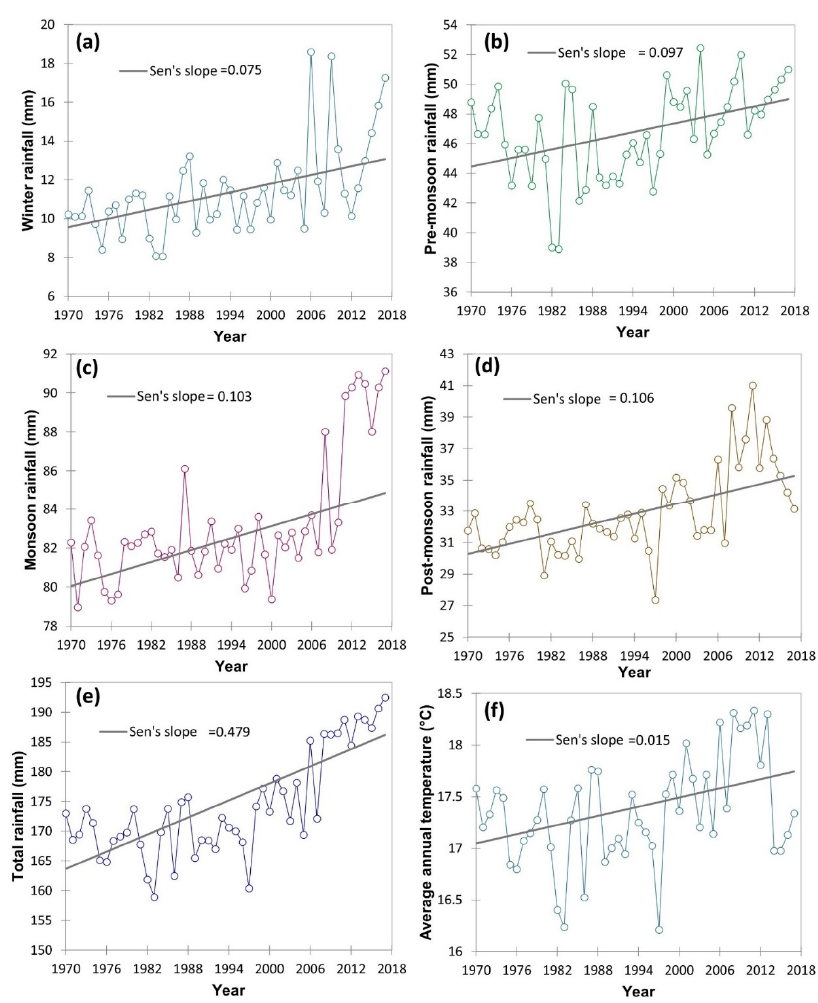
Figure 4. Time series trend analysis of different rainfall attribute variations including average annual temperature (°C) from 1970–2017 including four different seasons of the year using Mann– Kendall statistics and Sen’s slope. Here: ( a ) winter rainfall (mm); ( b ) pre-monsoon rainfall (mm); ( c ) monsoon rainfall (mm); ( d ) post-monsoon rainfall (mm); ( e ) total rainfall (mm); ( f ) average annual temperature (°C).